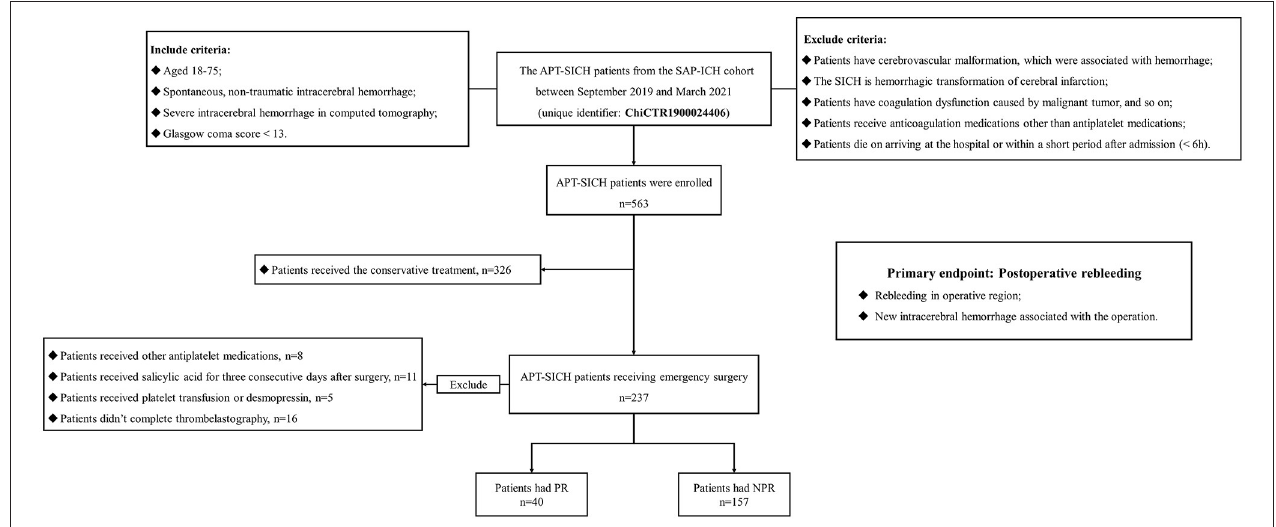
FIGURE 1 | The flowchart of patient enrollment. A total of 563 eligible APT-SICH were enrolled. Of them, 221 patients received emergency surgery. We further excluded 8 patients taking other antiplatelet medications, 11 patients receiving salicylic acid for three consecutive days after surgery, five patients receiving transfusion or desmopressin, and 16 patients without thrombelastography. Finally, 197 patients were included in this study. APT-SICH, patients with severe spontaneous intracerebral hemorrhage on antiplatelet